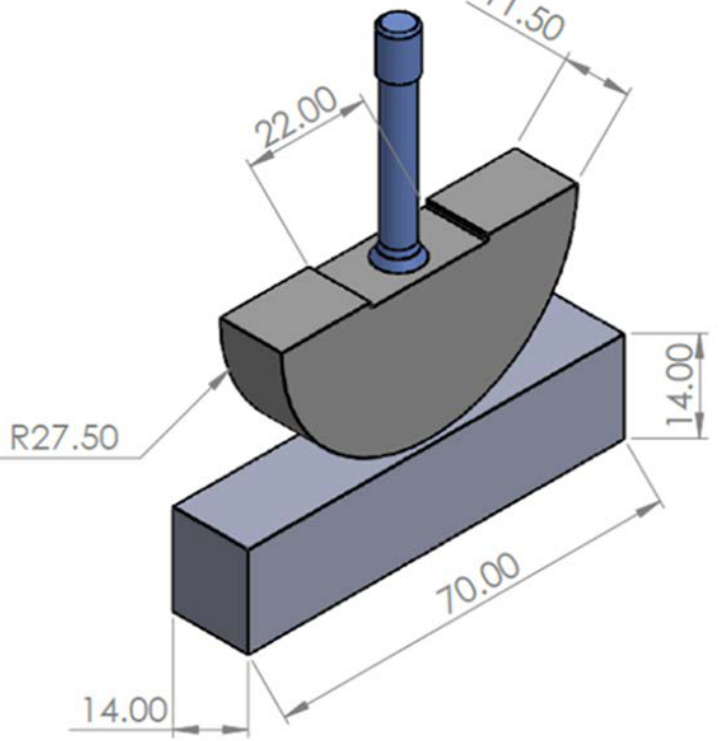
Figure 1. Dimensions for cylindrical and plane specimens used for tests.